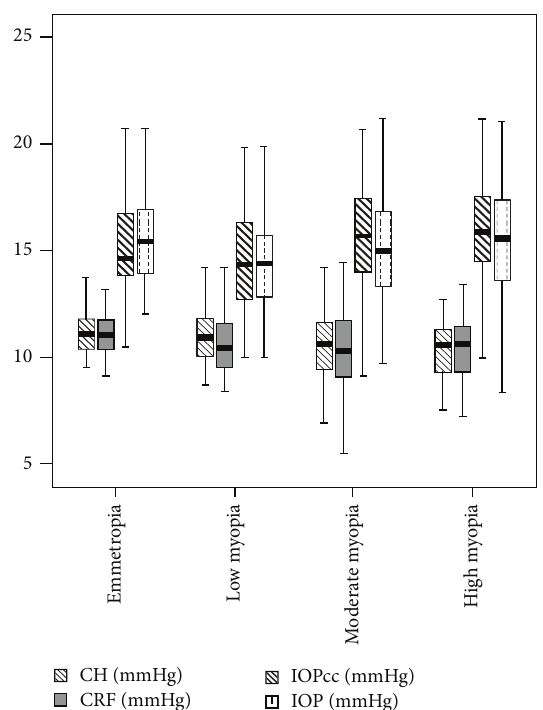
Figure 1: Box-and-whisker plot for corneal hysteresis (CH) and corneal resistance factor (CRF) and noncontact tonometer intraoc- ular pressure (IOP) and corneal compensated intraocular pressure (IOPcc). Average and standard deviation values are presented in